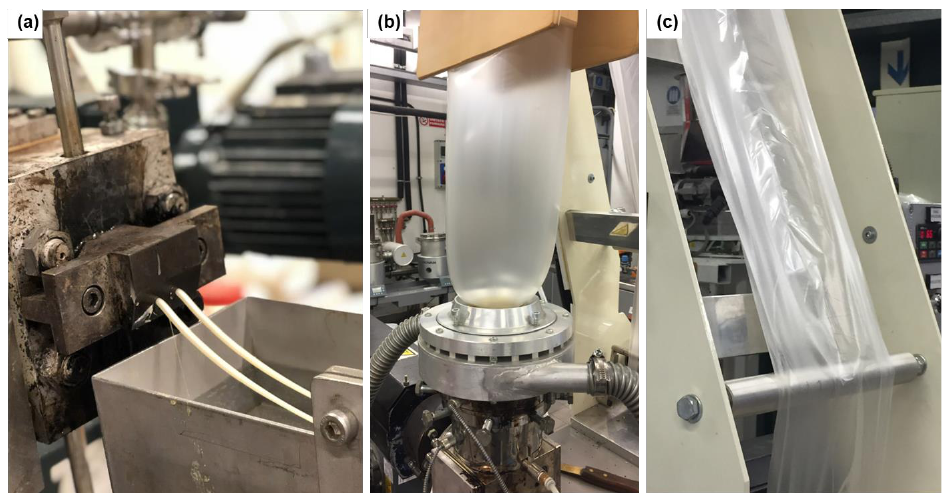
Figure 1. Material preparation process: ( a ) melt extrusion for blending PLA-PHB, OLA, and CNCs or ChNCs; ( b ) film blowing process; ( c ) the final nanocomposite bag.